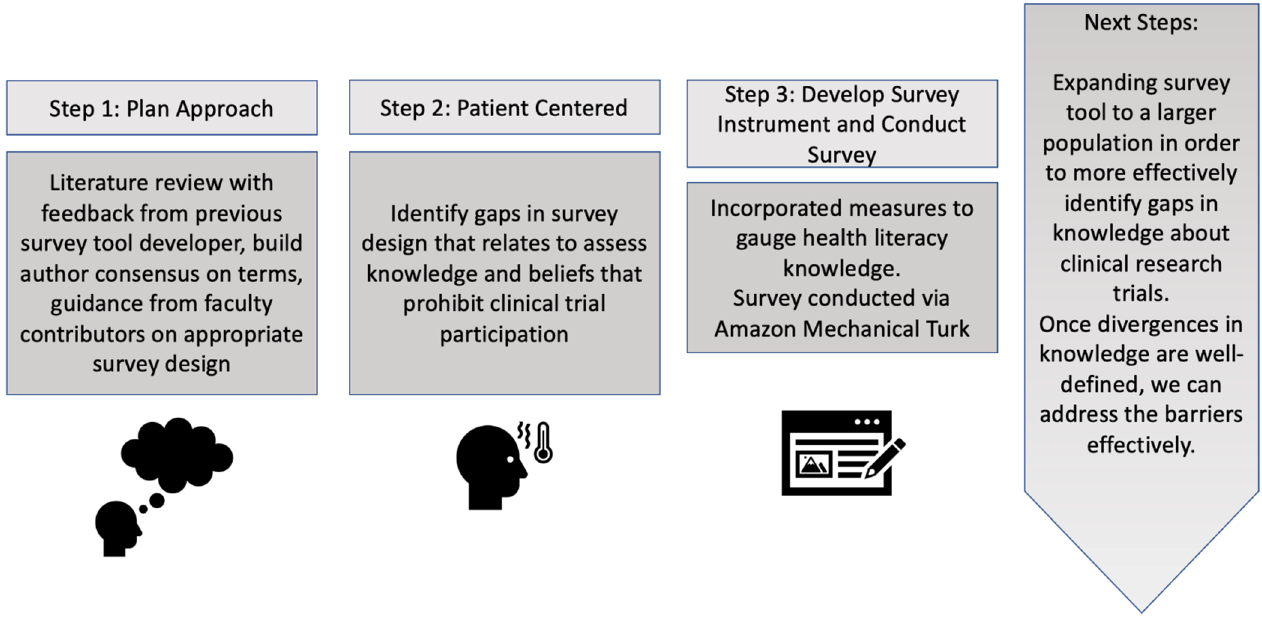
Figure 1. Clinical Trial Health Knowledge and beliefs Scale Development Process.